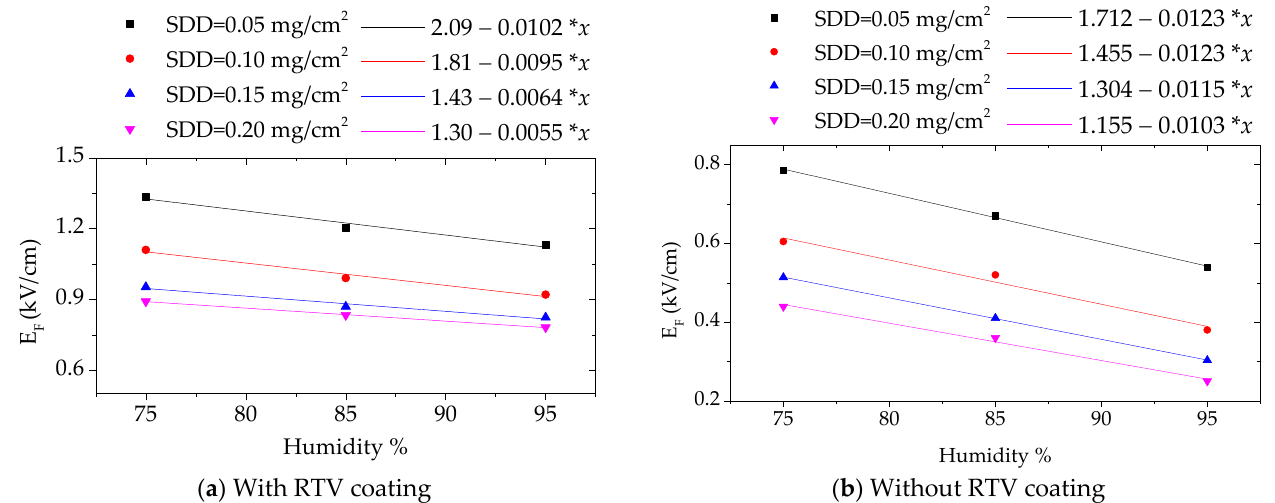
Figure 9. Flashover voltage gradient E F of polluted porcelain insulator string under different humidity levels: ( a ) with RTV coating; ( b ) without RTV coating.